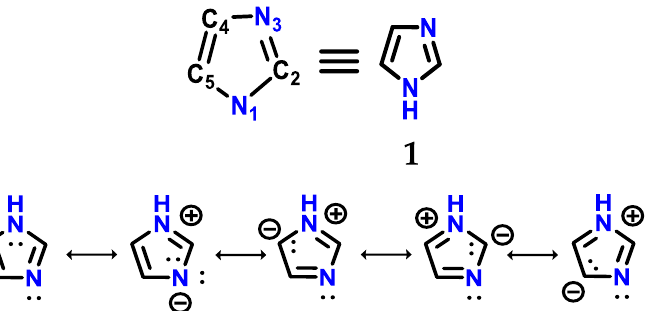
Figure 1. Structure of imidazole 1 with its respective numbering and resonance hybrids.